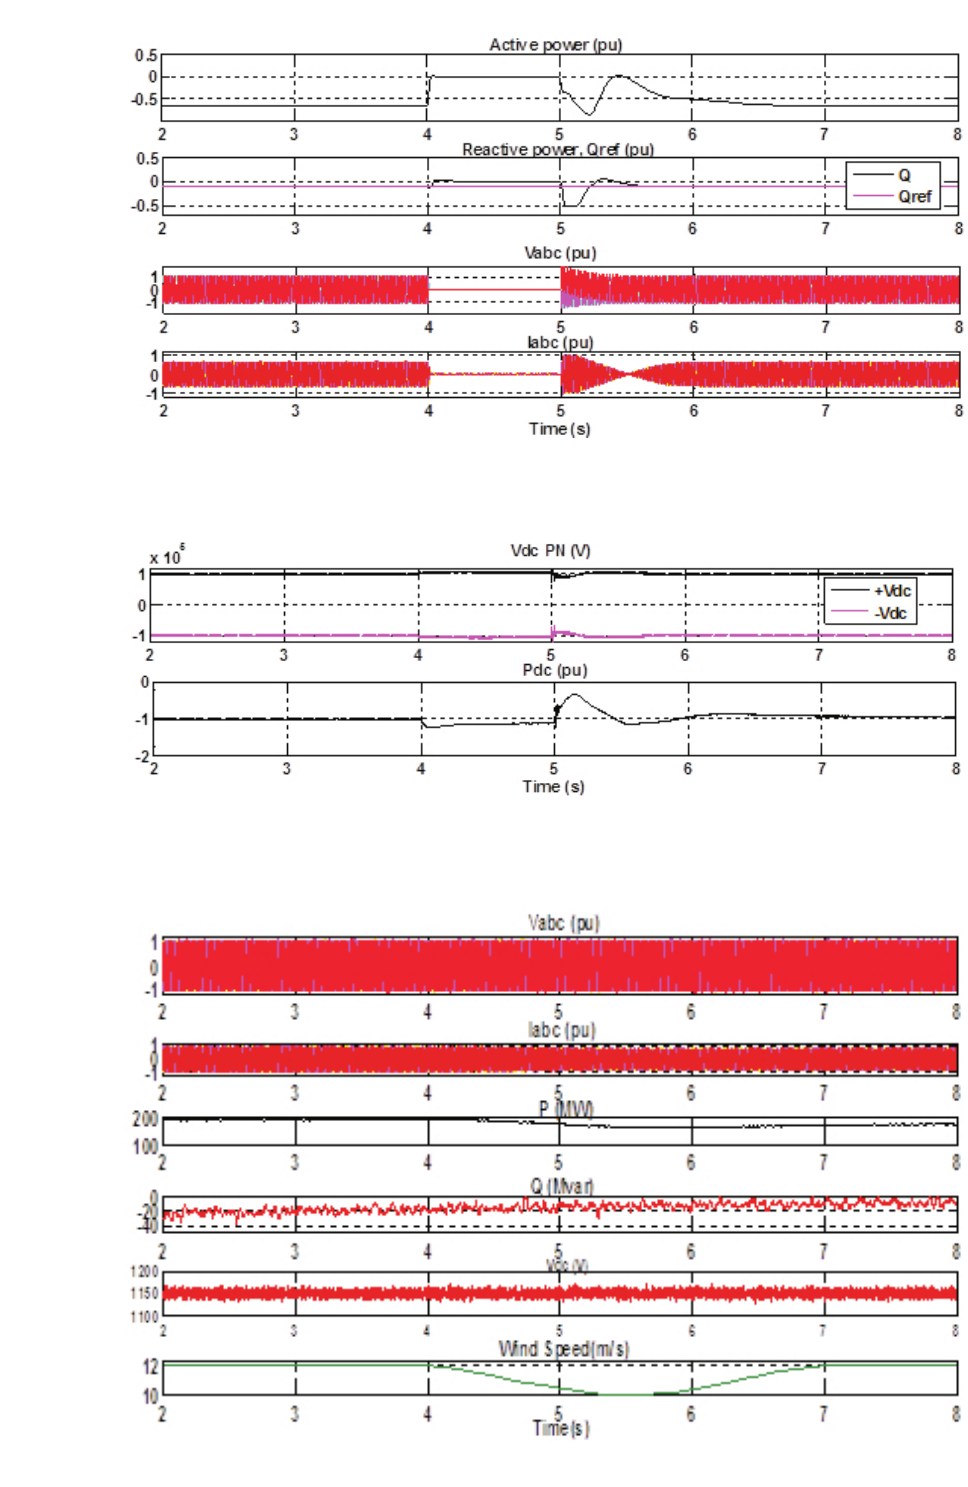
Figure 6: Dynamics of (a) VSC1 (b) VSC2 (c) VSC3 (d) VSC4 (e) DC link of VSC 2 and (f) Wind farm parameters for a converter outage